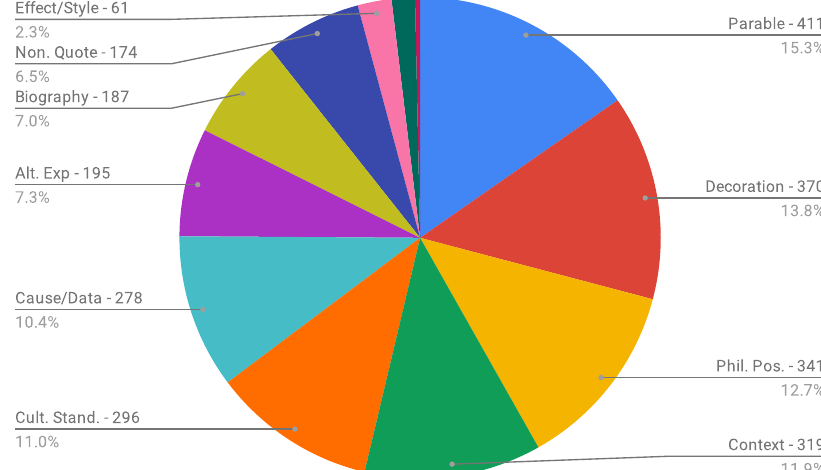
Fig. 2 Typography of literary uses in social science articles. Chart shows the proportion of literary typographies across JSTOR ’ s social science catalog from among our compiled search term list. The presented types originate from our expanded typography based on Watts ’ s